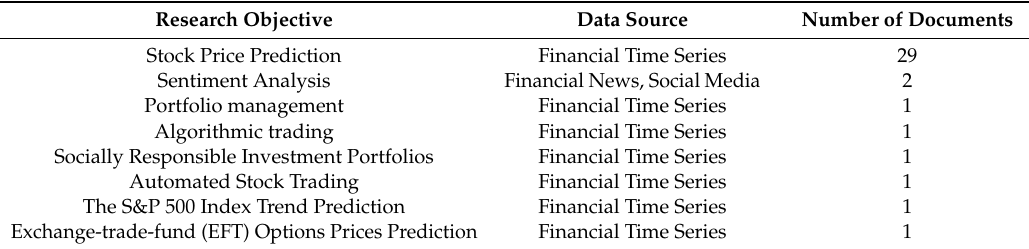
Table 3. Classification of articles using data science by research purpose and data source in the stock market section.